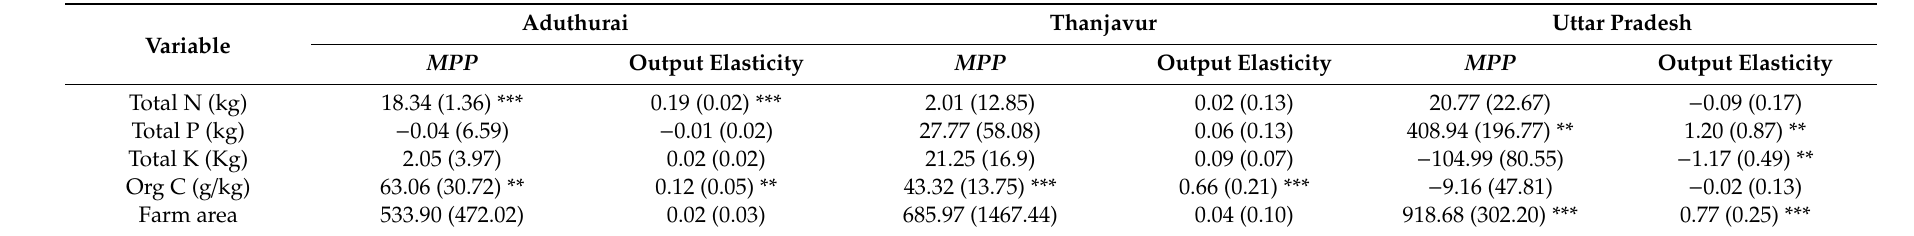
Table 7. Marginal physical product ( MPP ) and output elasticity values at the mean level in India. Variable